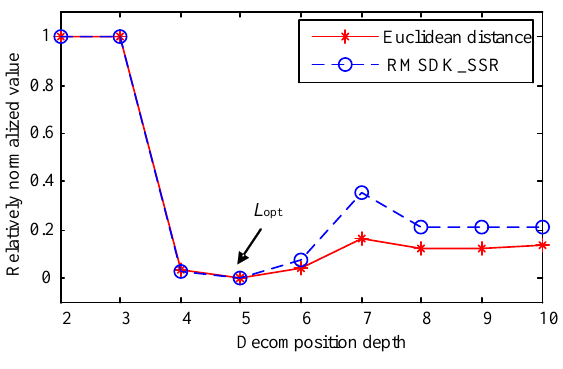
Figure 9. Comparison between the added and the extracted particle